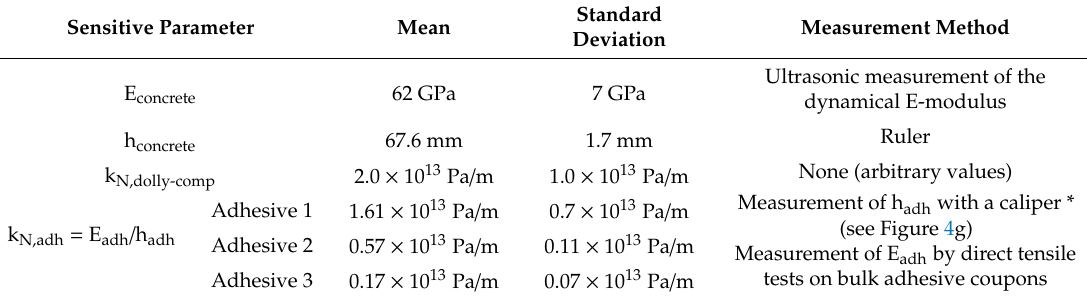
Table 4. Sensitive parameters: means, standard deviations and measurement